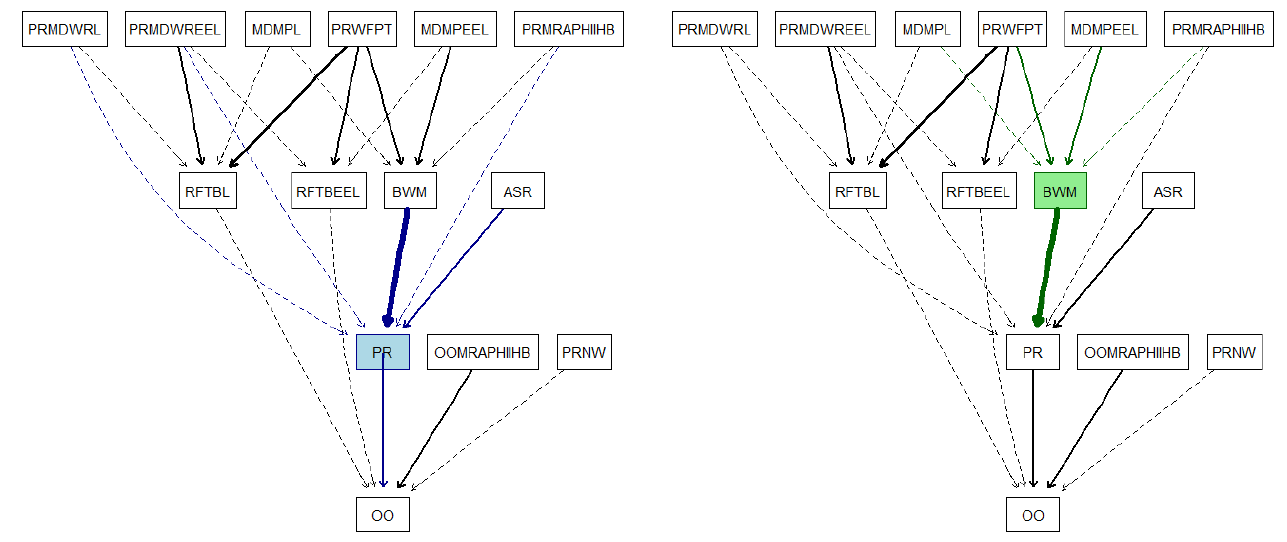
Figure 2. DAG showing in more detail the nature of the relationships between the variables included in the study. Table 4. Parameters of node “buying with mortgage” (Gaussian distribution; conditional density).